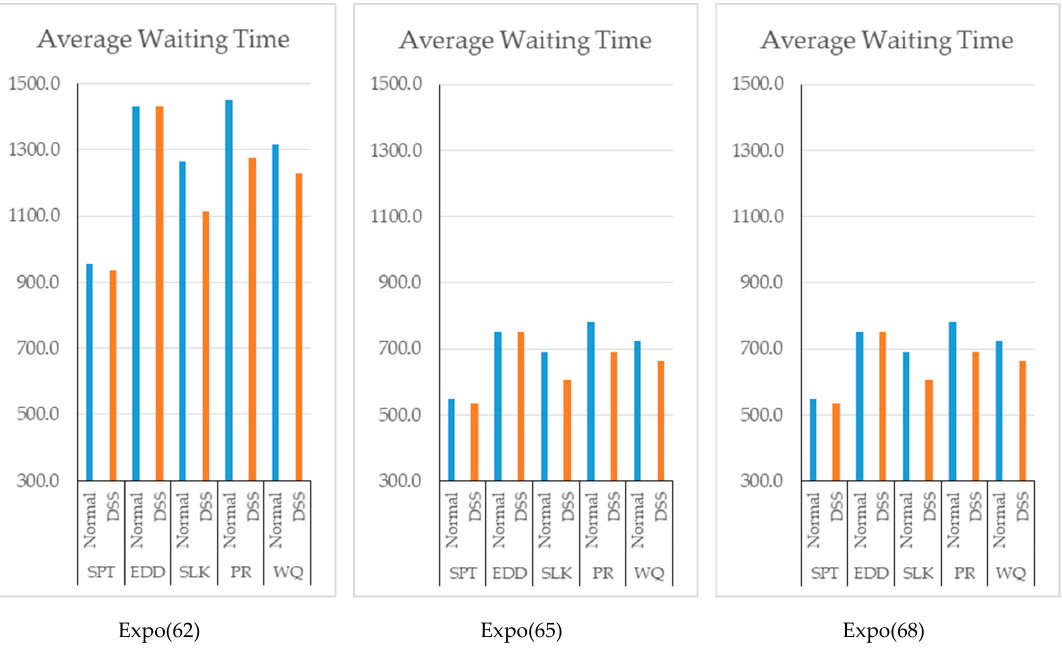
Figure 6. Average waiting time.